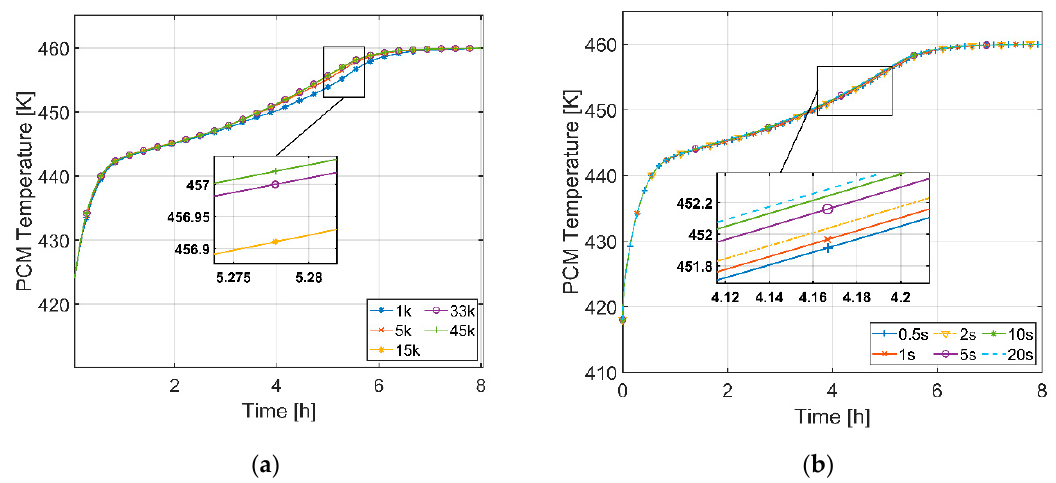
Figure 4. Independence tests ( a ) Grid size ( b ) Time step size